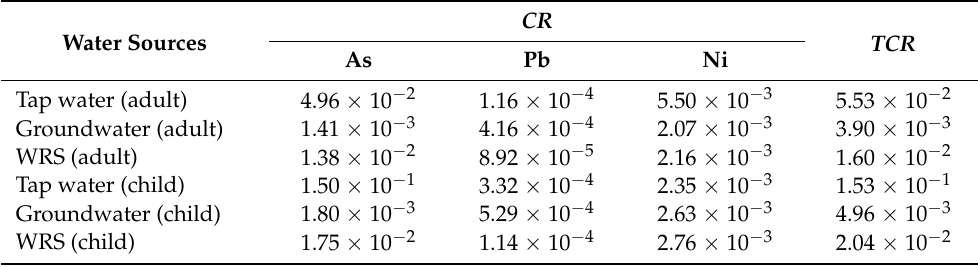
Table 10. Mean total carcinogenic risk parameters ( TCR ) of metals in the domestic water.